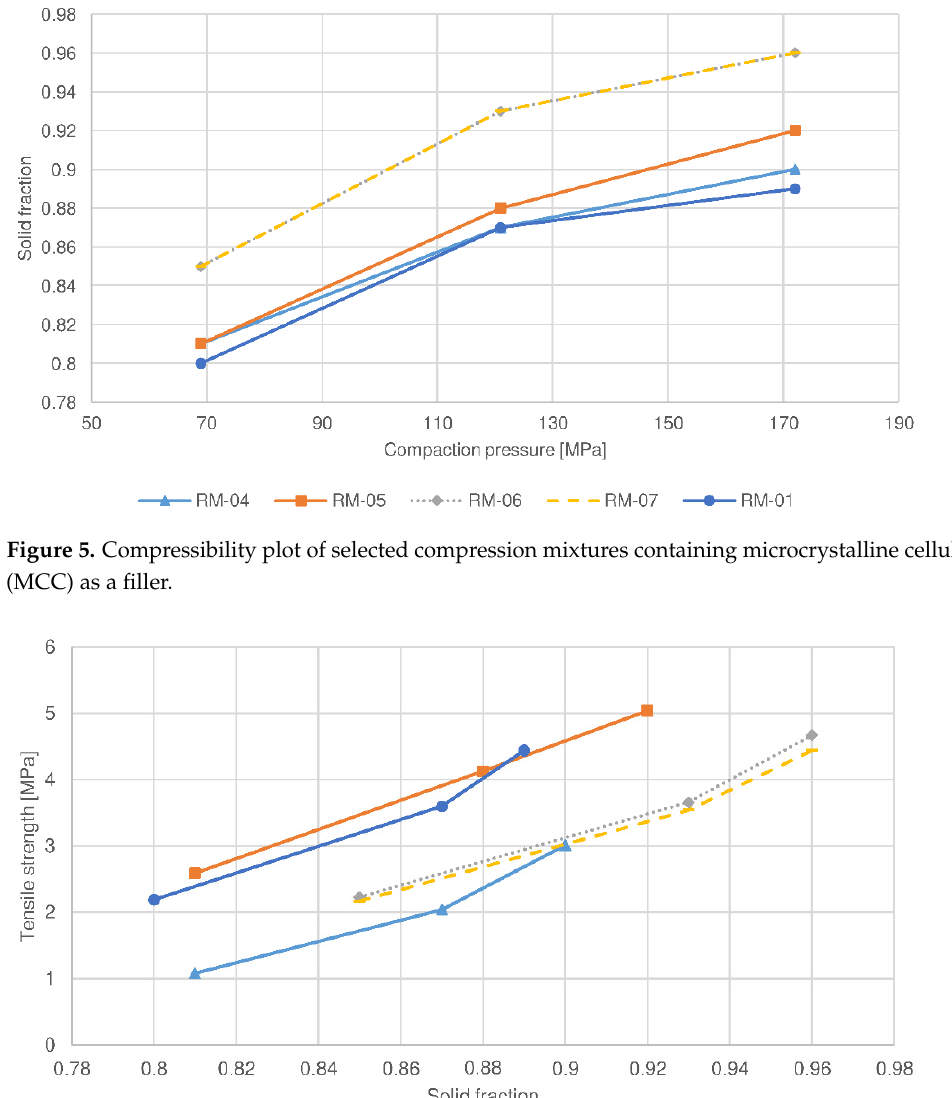
Figure 4. Compactibility plot of selected compression mixtures containing lactose as a filler.